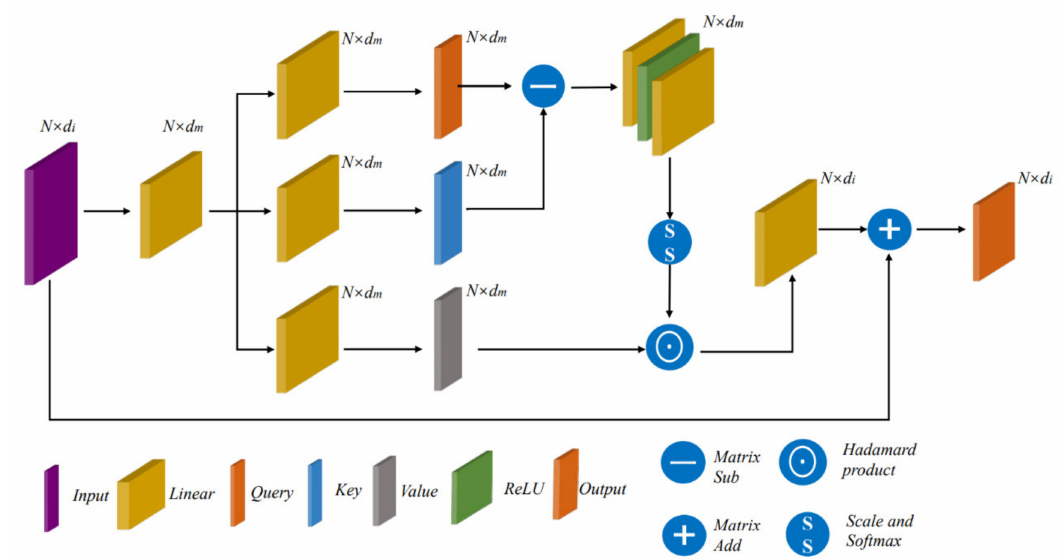
Figure 4. The structure of vector attention